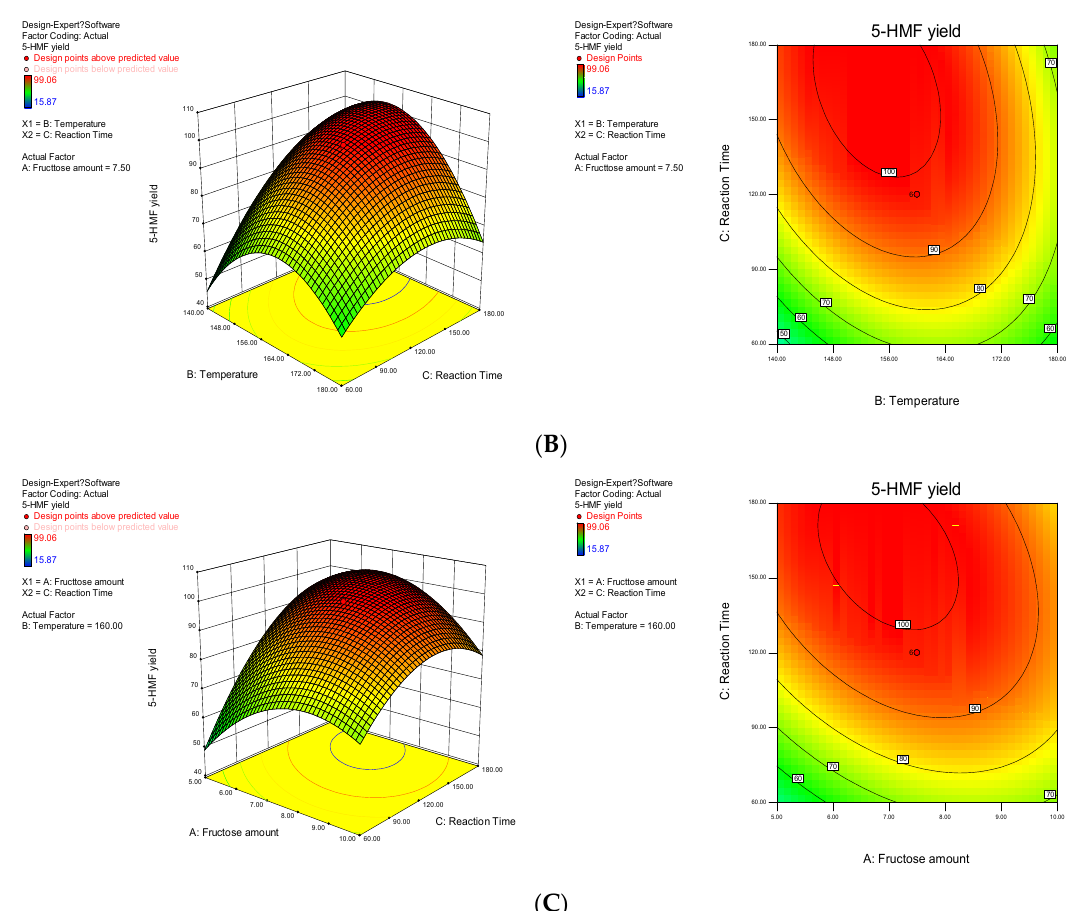
Figure 5. Response fitted surface area and contour plot for 5 ‐ HMF yield based on ( A ) temperature and fructose loading; ( B ) reaction time and temperature and ( C ) fructose loading and reaction time.